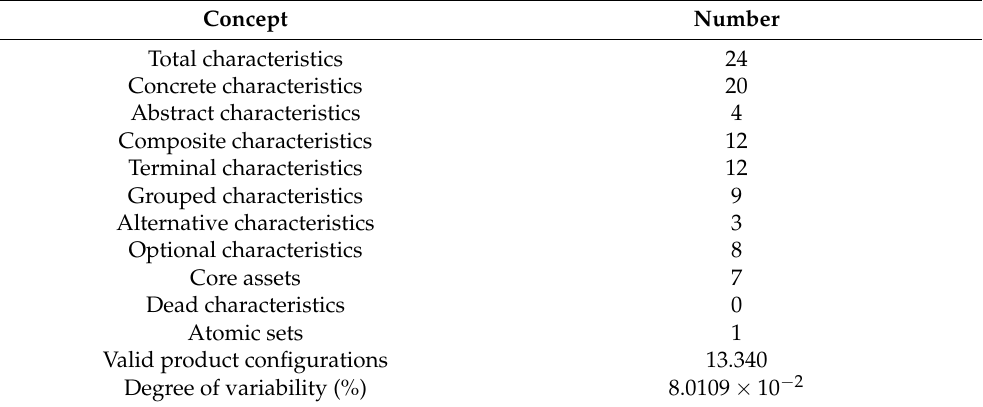
Figure 1. Feature model proposed for the SPL developed for industrial robots with Arduino. Table 1. Syntactic and semantic statistics of the feature model for